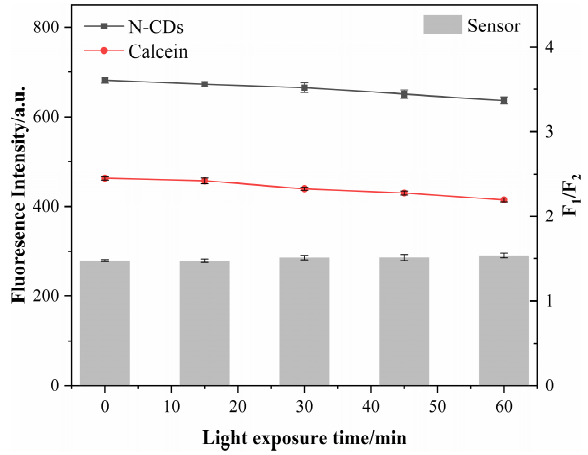
Figure 9. Effect of light exposure time on the fluorescence intensity of N-CDs, calcein and N-CD/calcein sensor.